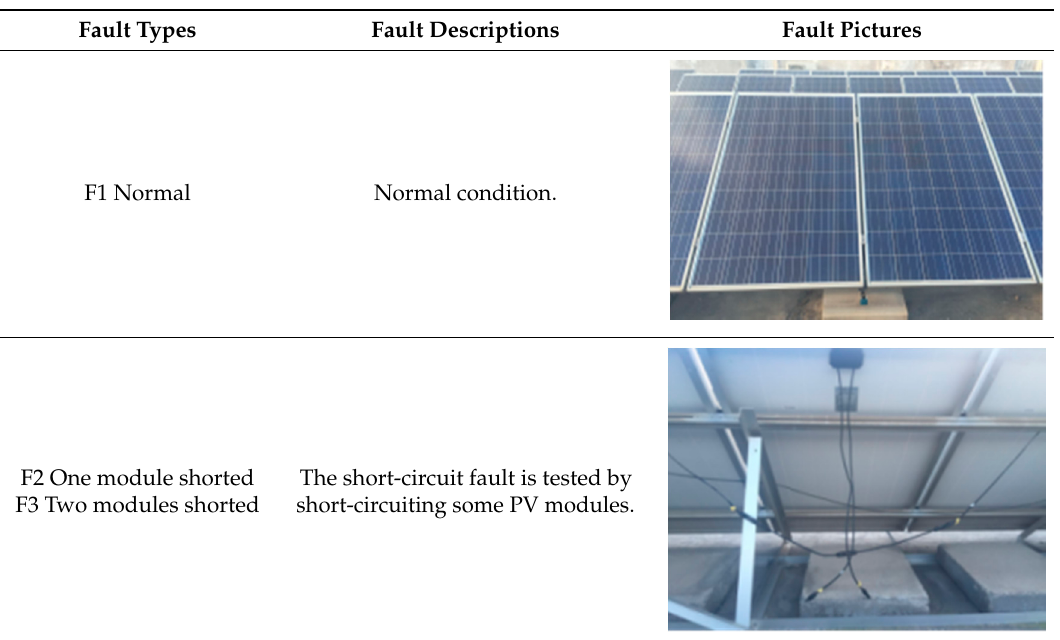
Table 11. Experiments description.